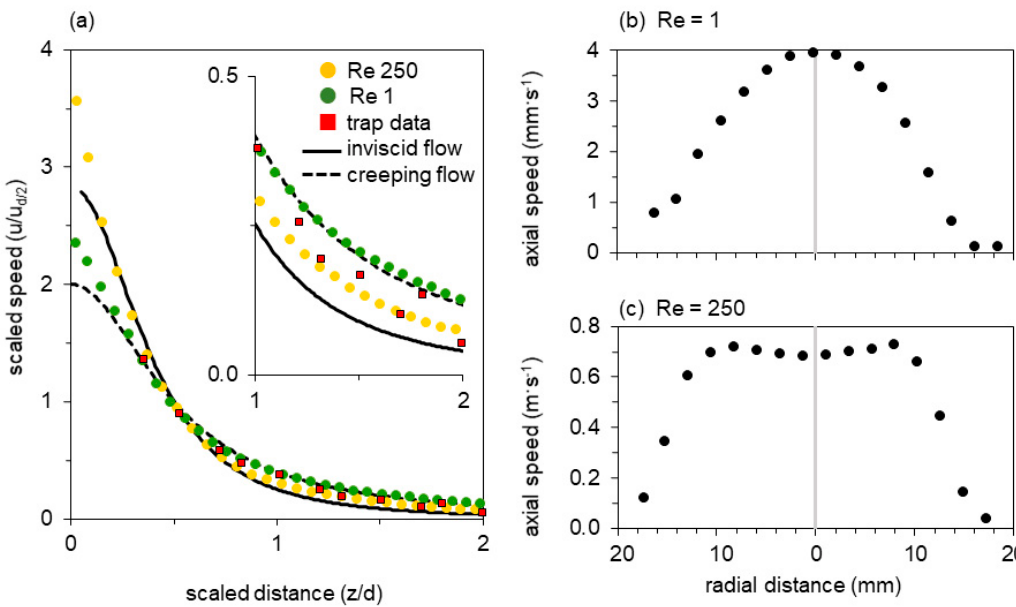
Figure 5. Transects through the flow fields of the mechanical model at Re 1 and Re 250 as indicated in Figure 4. ( a ) Fluid speed as a function of distance from the mouth along the axial transect, showing distances normalized by gape and flow speeds normalized by the speed at half gape. Both axes have been scaled to match the dimensionless theoretical curves for entry flow to a circular pipe: inviscid flow (solid line) and creeping flow (dashed line), see main text (Discussion). Thus data and theory necessarily intersect at distance = 1 / 2, speed = 1. ( b , c ) Fluid speed as a function of position along a transverse transect within the nozzle for (b) Re = 1 and (c) Re = 250.